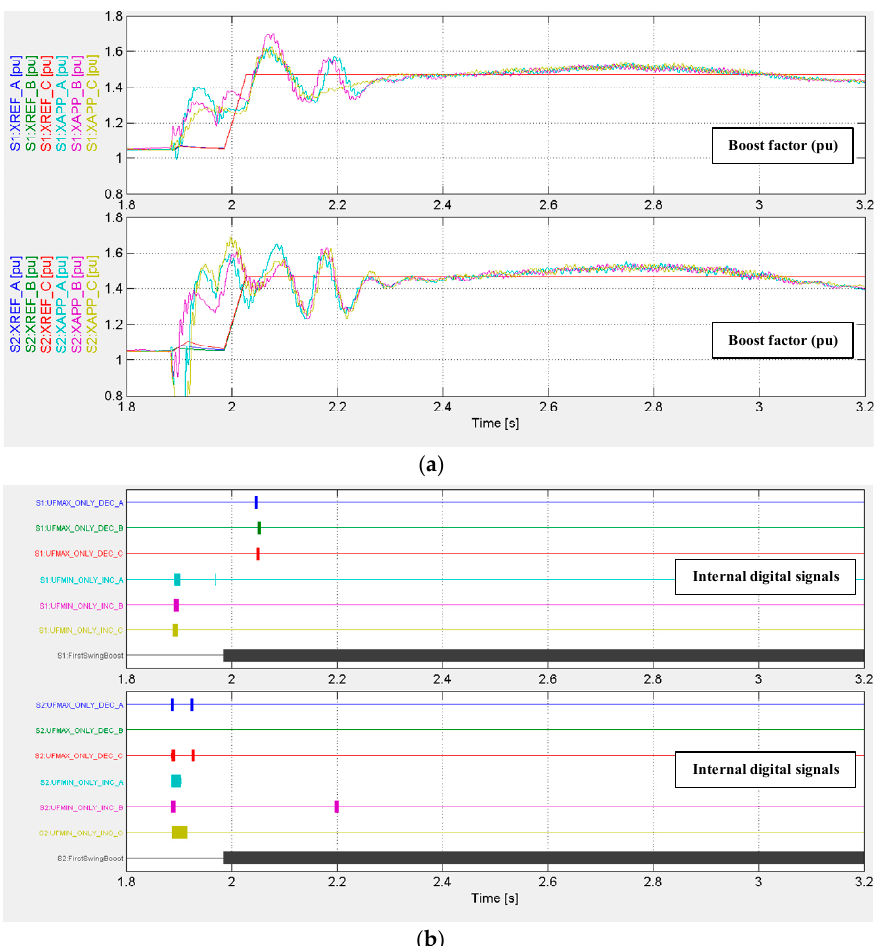
Figure 9. Instantaneous output increase control performance test results in case of 765 kV failure. ( a ) Boost factor in case of 765 kV failure, before relocation (top)/after relocation (bottom). ( b ) 765 kV failure TCSC internal control digital signal, before relocation (top)/after relocation (bottom).